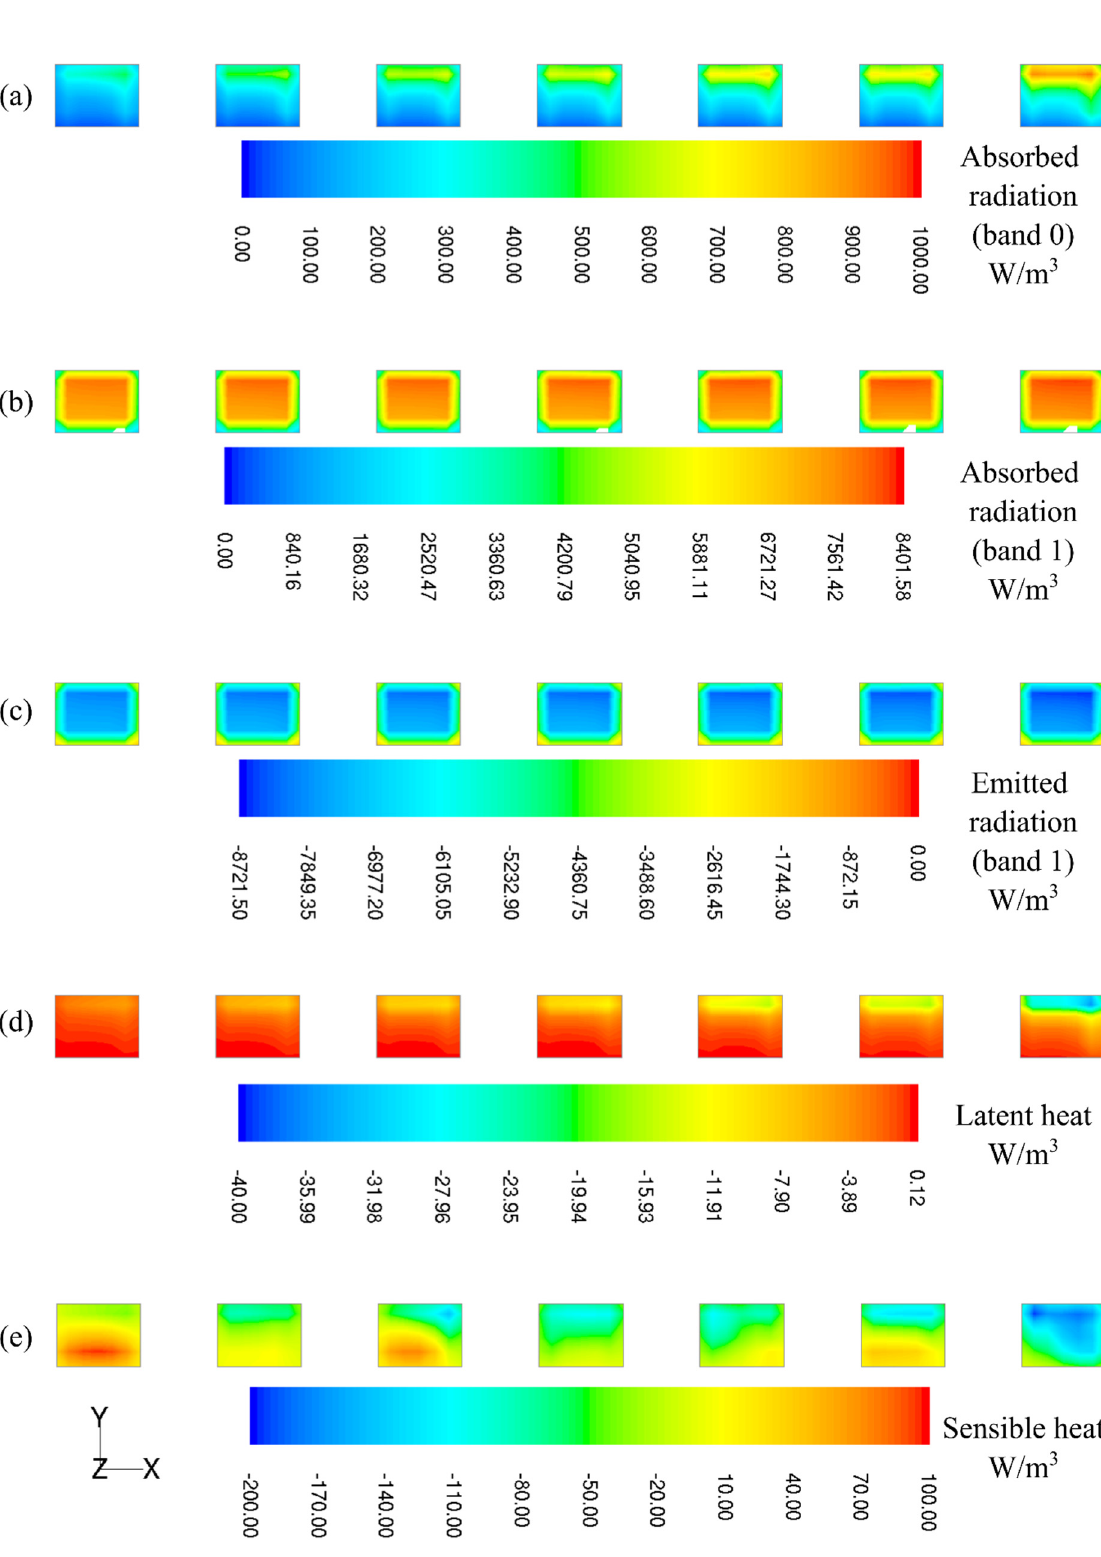
Figure 7. Crop energy exchange in W m − 3 at a distance z = 19 m from the door. ( a ) Radiative flux absorbed by the crop in the short wavelength band, ( b ) Radiative flux absorbed by the crop in the long wavelength band, ( c ) Radiative flux emitted by the crop in the long wavelength band, ( d ) latent heat exchange, and ( e ) sensible heat exchange.